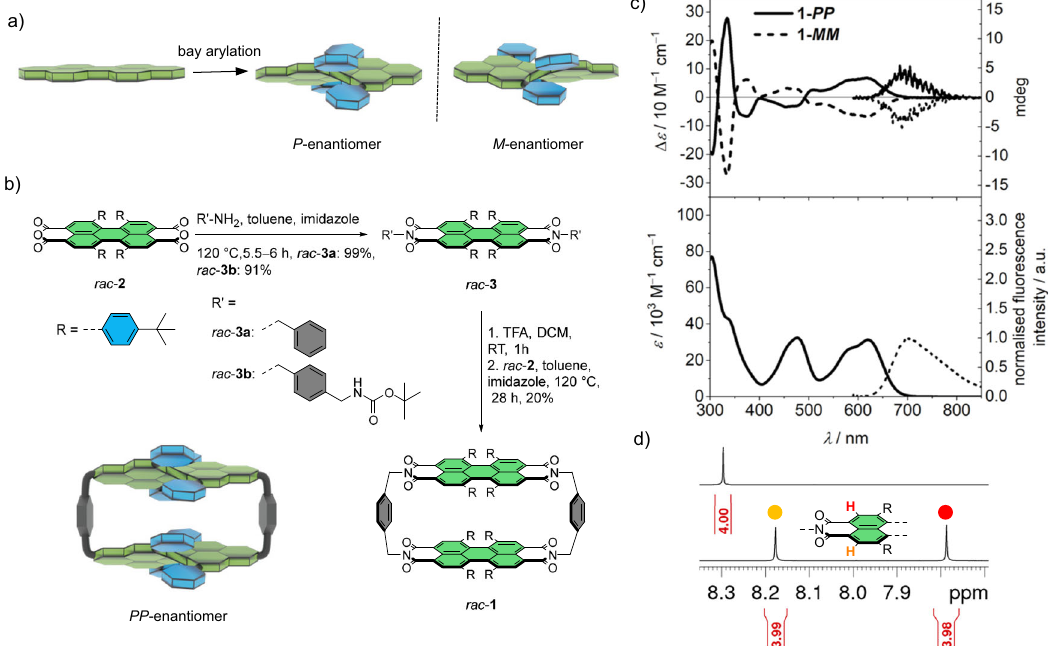
Fig. 1 | Synthesis and properties of chiral PBI cyclophane. a General concept of introducing helical chirality to PBIs by bay-arylation. b Synthesis of racemic per- ylene bisimide cyclophane rac - 1 and monomeric reference rac - 3a and schematic depiction of the PP -cyclophane. c Circular dichroism and CPL spectra of 1- PP and